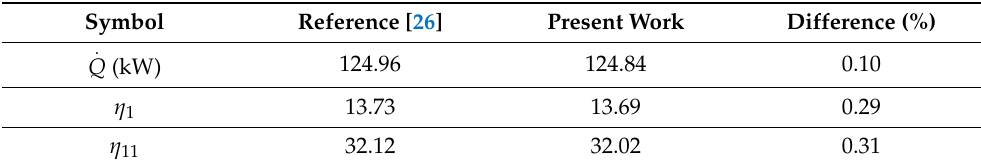
Table 6. Comparing the overall results of this study with those of Shu et al.